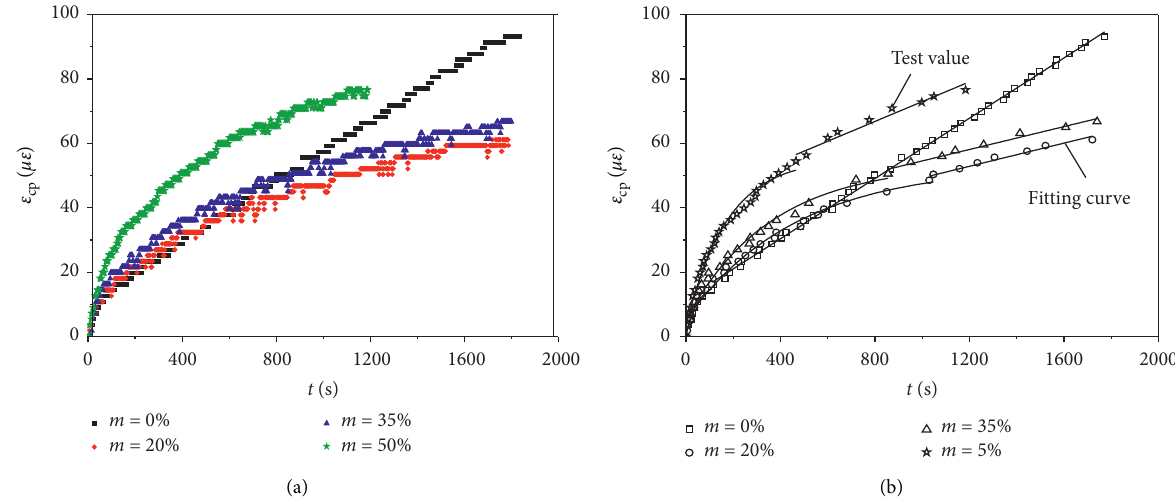
Figure 8: Experimental and fitted creep-stain curves of concrete with various fly ash replacement ratios ( m ) during the decelerating/ isokinetic creep stage. Table 4: Fitting parameters of concrete with various fly ash replacement ratios during the decelerating creep stage. Parameter